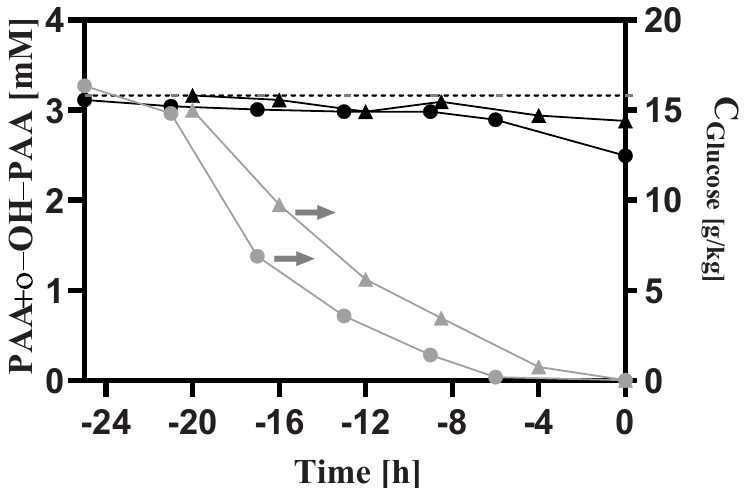
Figure 7. Measured concentrations of PAA, o-OH-PAA and glucose during the batch process. The dash line represents the initial PAA concentration in the bioreactor. The symbols in black, red and green denote the results obtained from Penicillium chrysogenum Wisconsin 54-1255, Penicillium chrysogenum ∆ tps1 and Penicillium chrysogenum ∆ tps2 , respectively. Time 0 represents the start-up of chemostat